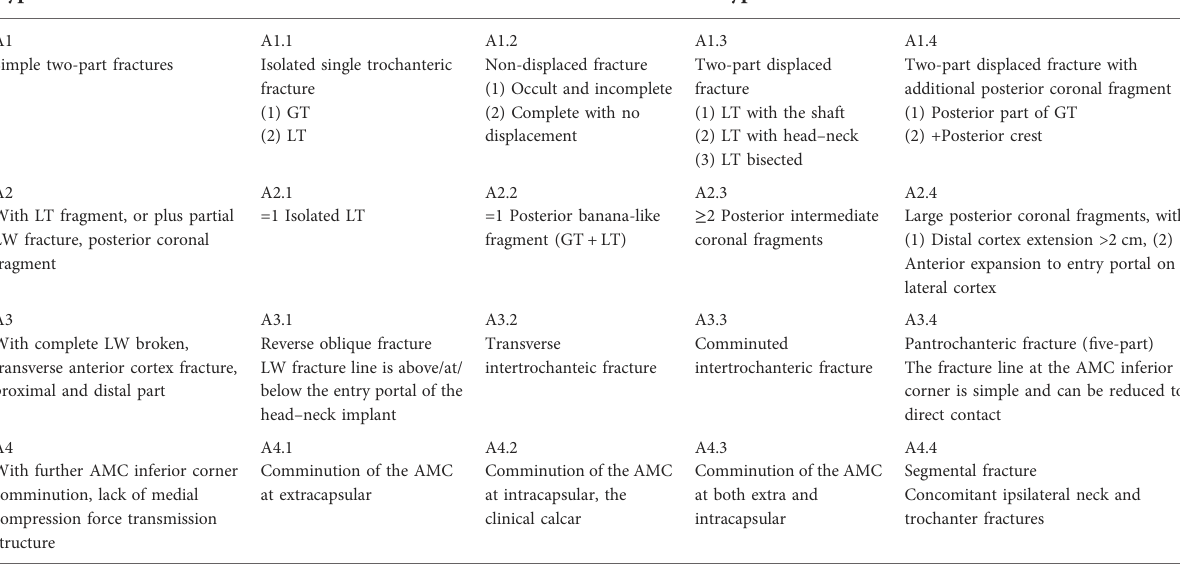
TABLE 1 A sophisticated fracture classi fi cation of proximal femur trochanteric region